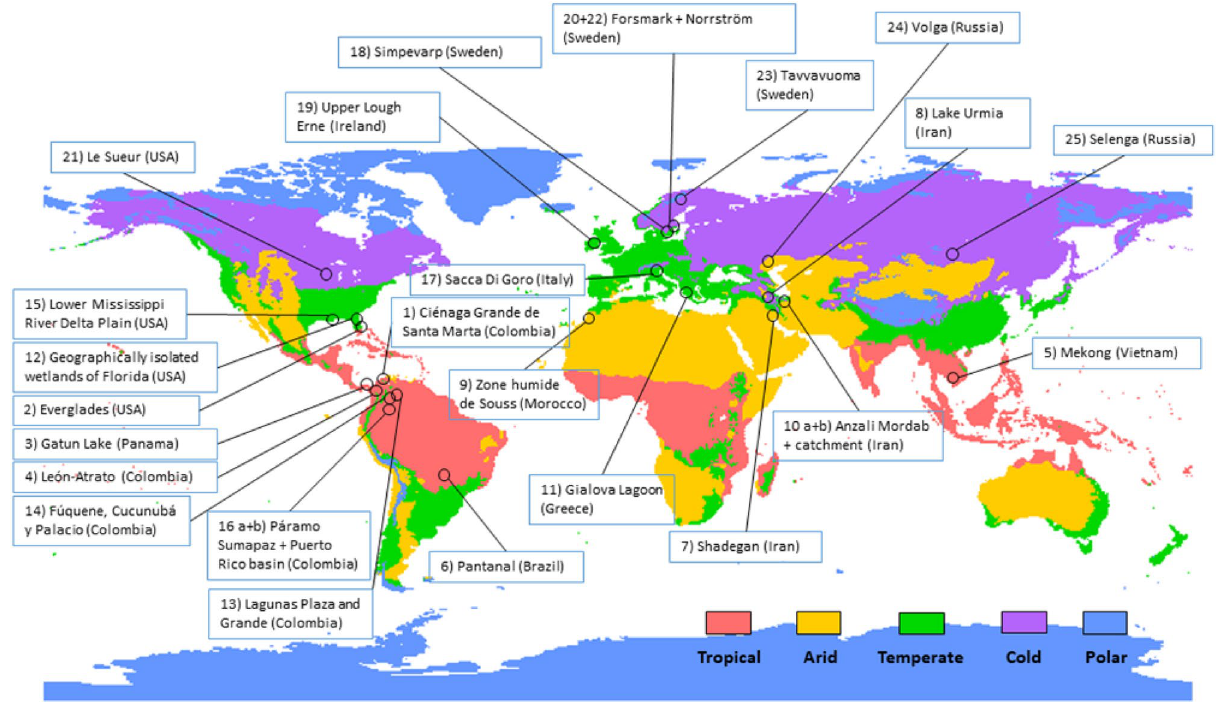
Figure 6. Map over the 25 studied wetlandscapes. Distribution of the 25 GWEN wetlandscapes included in this study over four of the five main climate zones (Tropical, Arid, Temperate and Cold), classified according to the Köppen-Geiger climate classification system (Kottek et al., 2006). The wetlandscape site numbers correspond to the ID numbering in Table 1. This map was created by the authors using QGIS 3.12.2 (https:// www. qgis. org/ en/ site/ forus ers/ visua lchan gelog 312/ index.